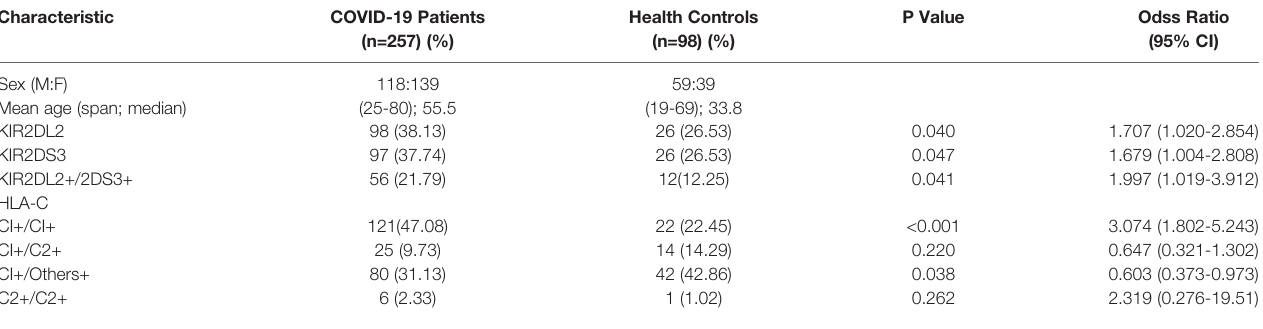
TABLE 1 | Clinical characteristics and the frequencies of KIR2DL2, KIR2DS3, and HLA-C1 in COVID-19 patients and healthy persons.